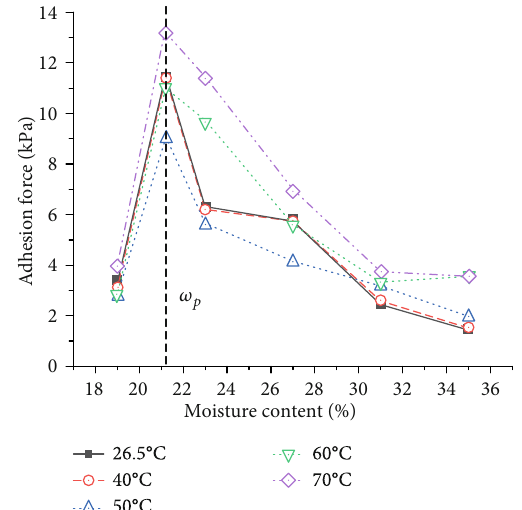
Figure 4: The curves of the change of the adhesion force with moisture